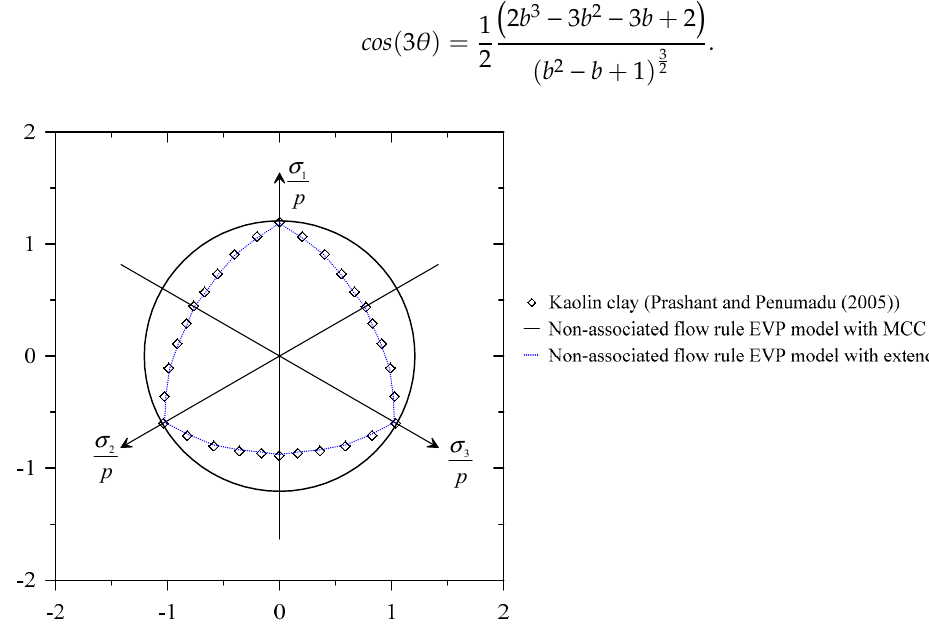
Figure 4. In the π -plane, comparison of the true triaxial test (TTT) results with the original Modified Cam Clay (MCC) surface and the extended MCC surface (for TTT test results see also Prashant and Penumadu [28]).